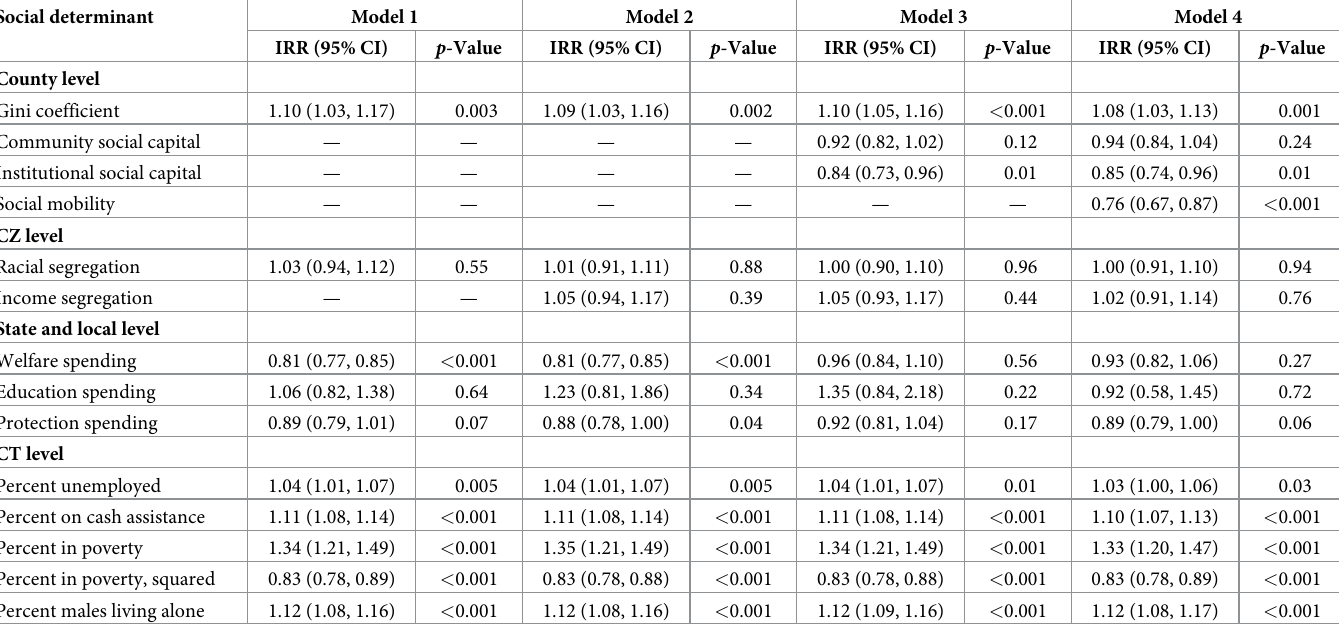
Table 3. Social determinants and the total number of non-mass shooting homicide incidents at the CT level in the contiguous US,